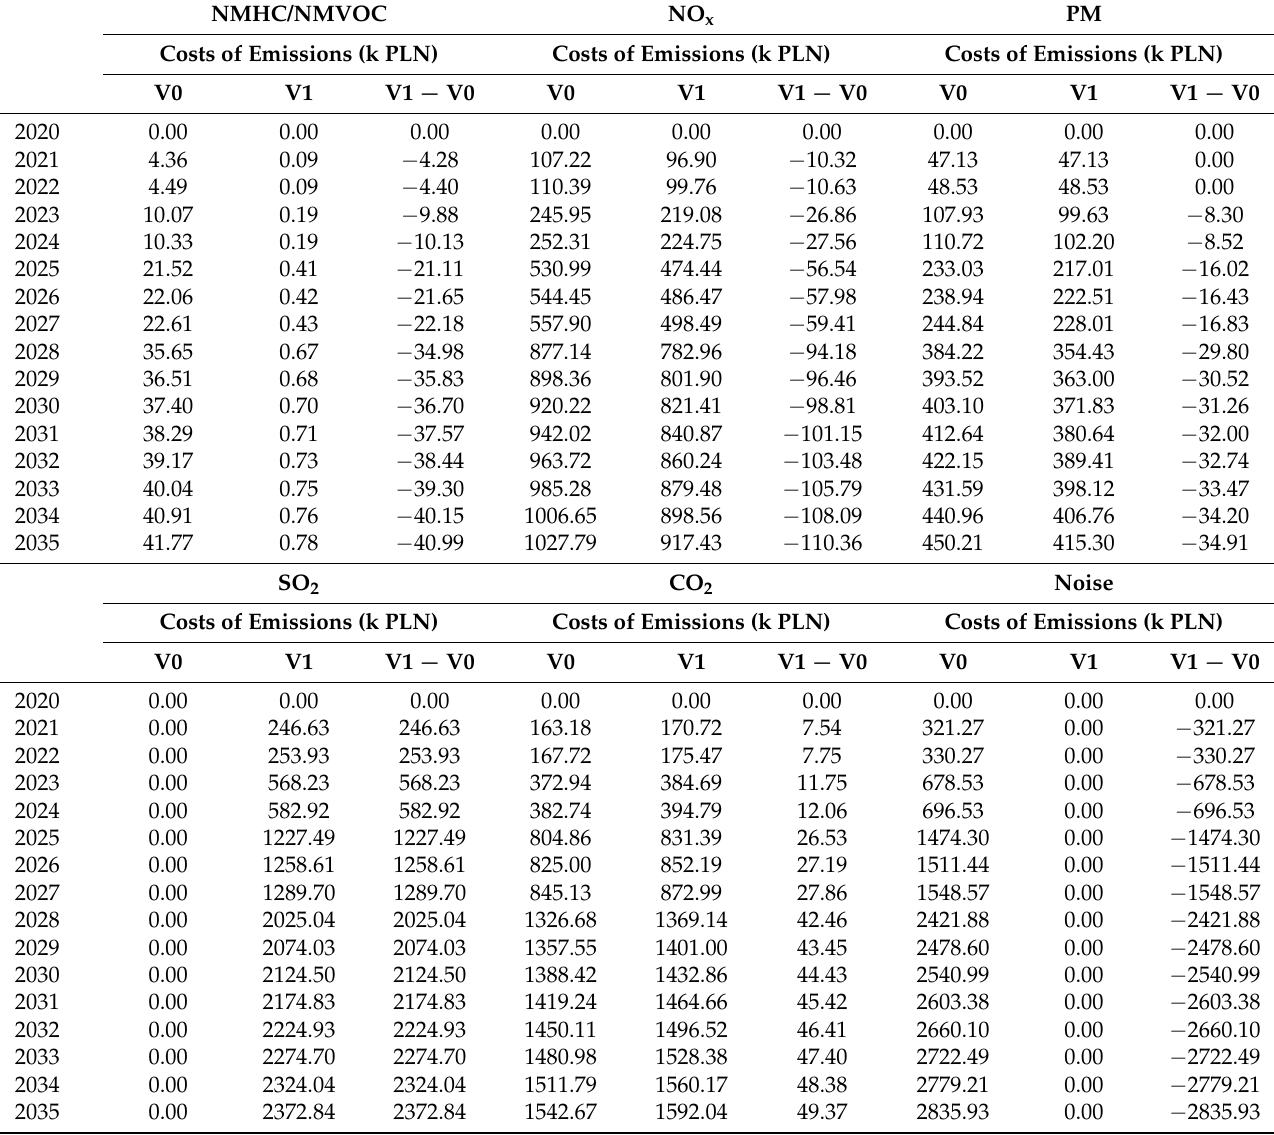
Table 6. Costs of NHMC/NMVOC, NOx, PM, SO 2 , CO 2 and noise emissions for: V0, V1 and V1 −